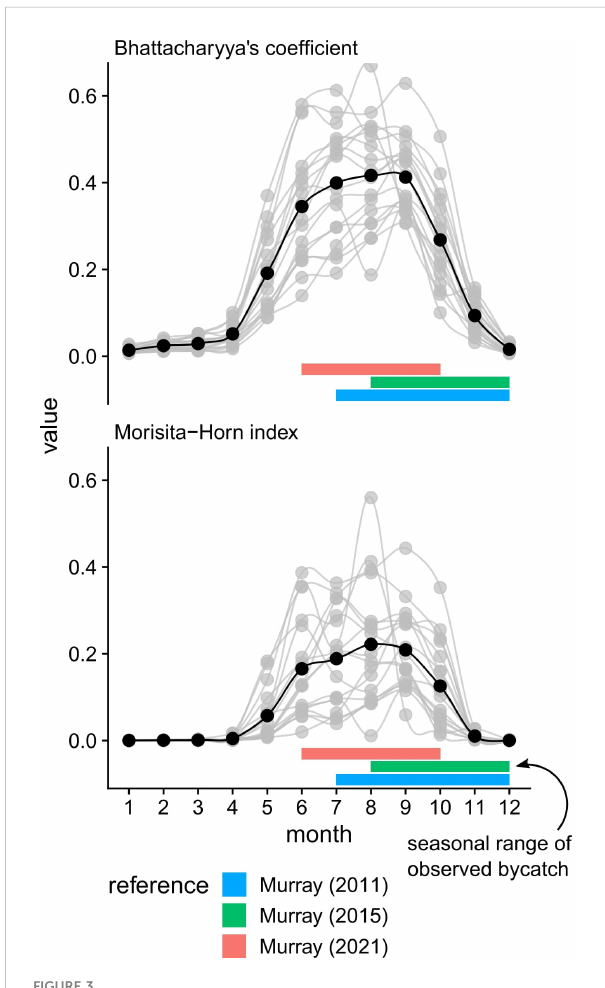
FIGURE 3 Monthly values of the overlap metrics for each calendar year (light grey dots and lines). Superimposed on the overlap metrics is the average value (black dots and lines). Horizontal bars de fi ne the seasonal range of observed loggerhead bycatch occurrence as documented by Murray (2011); Murray (2015); Murray